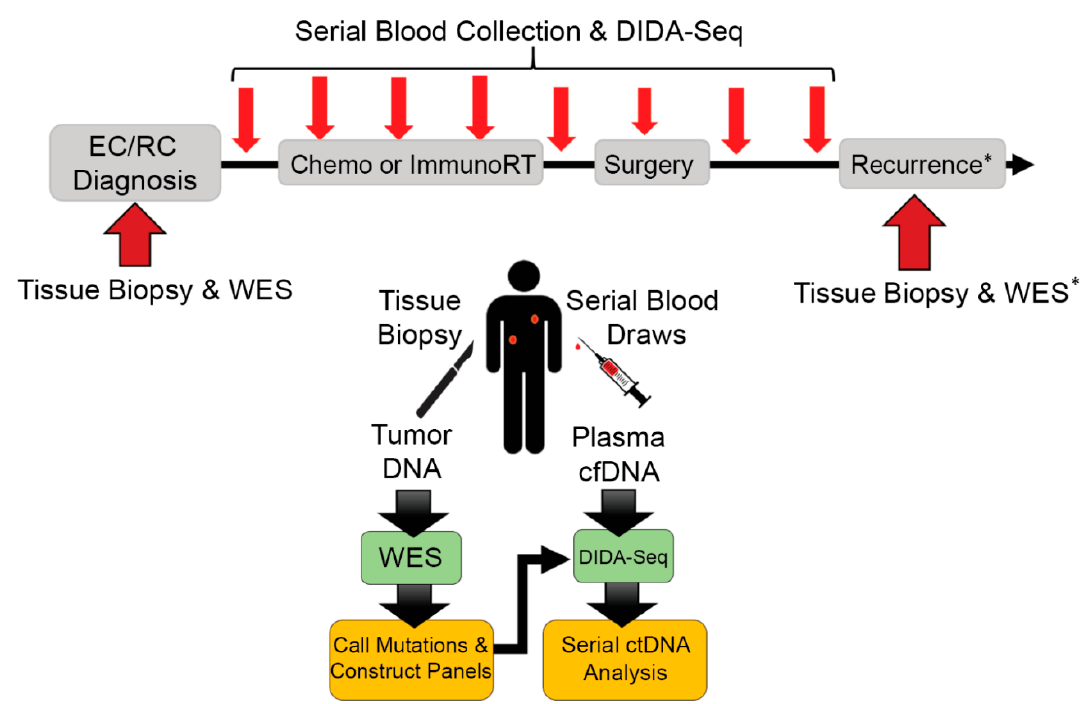
Figure 1. Patient treatment and sample collection schema for blood draws and solid tissue biopsies. Solid tissue biopsies were collected after initial diagnosis of esophageal or rectal cancer (ER/RC) and prior to treatment for whole-exome sequencing (WES). Blood was collected prior to Table 1. month intervals during treatment and surgery, and ~3-month intervals during follow-up monitoring. Mutations were called between solid tissue biopsy WES and matched buffy coat WES and used to construct patient-specific sequencing library enrichment panels. Cell-free DNA (cfDNA) isolated from blood draws was sequenced using Dual-Index Degenerate Adaptor-Sequencing (DIDA-Seq) at sites identified in each patient’s tumor biopsy to retrospectively determine circulating-tumor DNA (ctDNA) prevalence. *Patient 3 had a solid tissue biopsy of a metastasis which was also analyzed by WES and variants were included in their patient-specific panel.